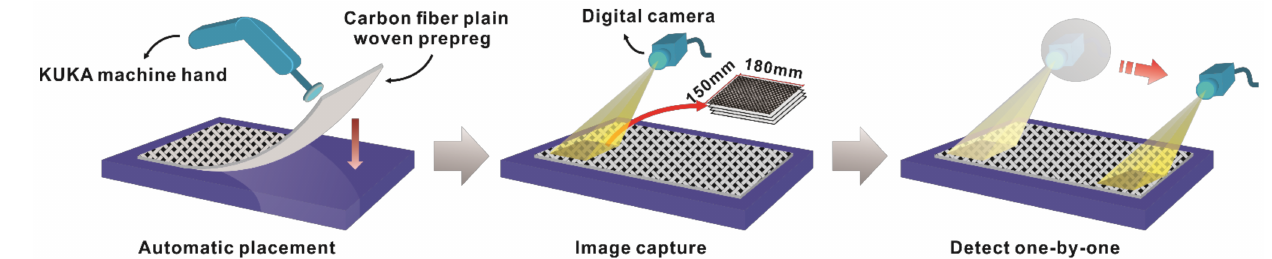
Figure 3. The process of defect inspection for carbon fiber plain-woven prepreg.